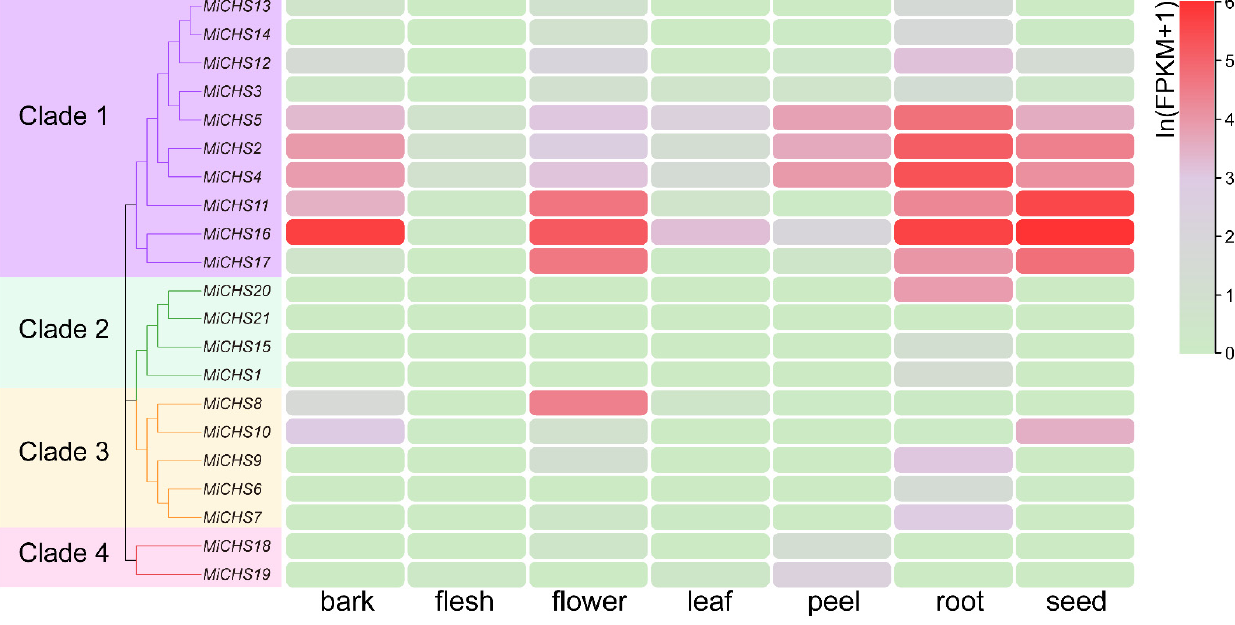
Figure 4. Hierarchical clustering of mango CHS expression profiles in different tissues. The 21 MiCHS genes are divided into Clades 1–4. The color of the bar represents the expression value.